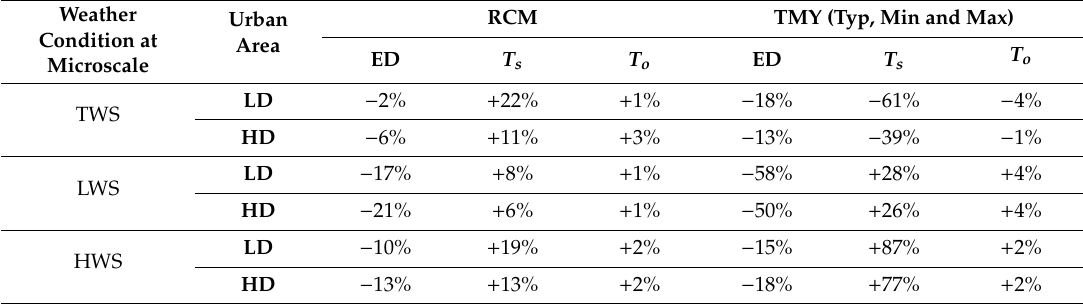
Table 2. The comparison between Micro data with RCM data and the TMY file based on